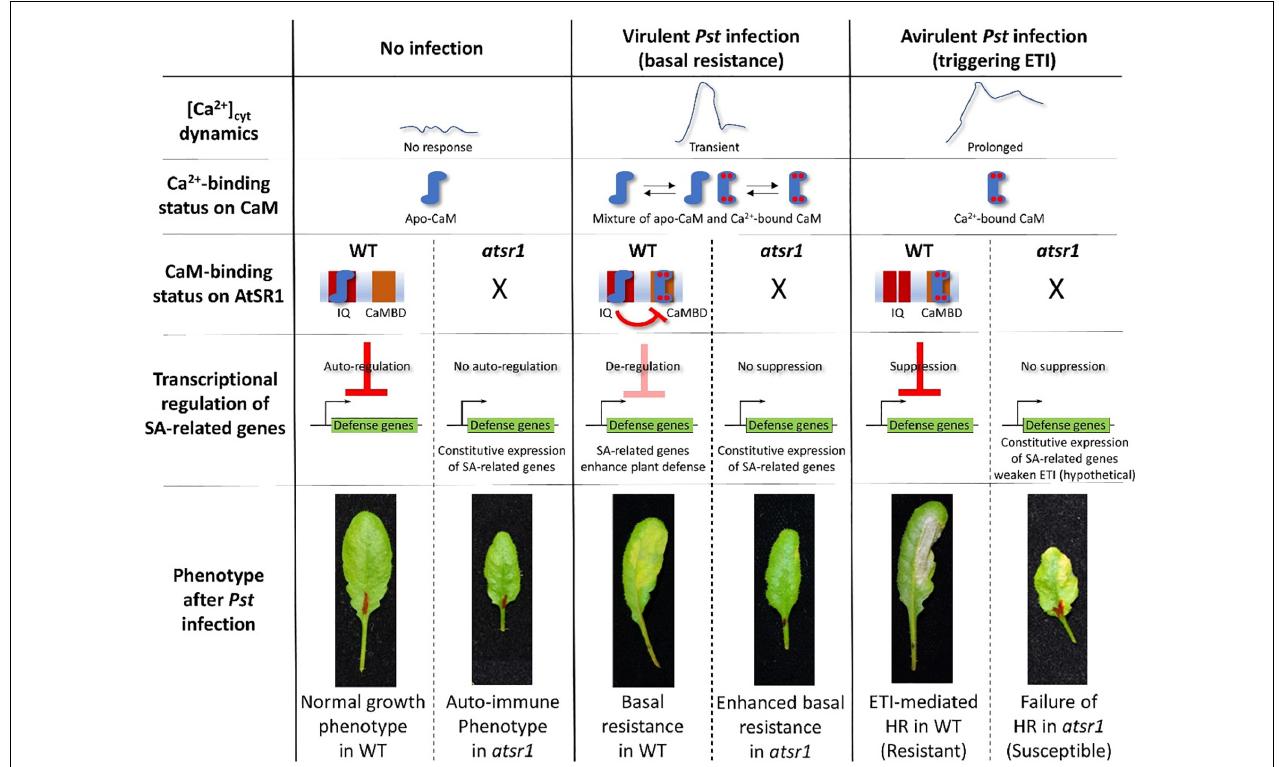
FIGURE 2 | AtSR1/CAMTA3 acts as a signaling switch with dependence on Ca 2 + -binding status of CaM during plant immune response. In non-stressful environments, there is no [Ca 2 + ] cyt dynamic. Hence, the status of CaM is not in a saturated phase at four Ca 2 + binding sites, designated as apo-CaM. Apo-CaM interacts with the IQ motifs of AtSR1. This CaM-AtSR1 complex may have an effect on the stability of AtSR1, which suppresses the transcriptional expression of defense-related genes (e.g., EDS1, ICS1, and NPR1 ) as an autoregulator. Thus, suppression of plant immunity maintains normal plant growth and development. Under the virulent pathogen infection, [Ca 2 + ] cyt is transiently increased, which confers a status of mixture of Apo-CaM and Ca 2 + -saturated CaM. Ca 2 + -saturated CaM interacts with the CaMBD of AtSR1, while Apo-CaM interacts with the IQ motifs. This CaM-AtSR1 complex loses its binding activity to the cis -regulatory element “CGCG,” and de-regulates the transcriptional expression of the defense-related genes. This eventually activates the basal resistance or PTI. Under avirulent pathogen infection, [Ca 2 + ] cyt is constitutively increased, which leads to stable binding of Ca 2 + ions to CaM. The Ca 2 + -saturated CaM interacts only with the CaMBD of AtSR1. This CaM-AtSR1 complex regulates the ETI-triggered PCD. In the atsr1 mutant, due to the loss of negative regulation of the NPR1 transcription by AtSR1, the plants constitutively activate basal immune response, resulting in the autoimmune phenotype. Under pathogen infection in the atsr1 mutant due to the lack of fine-tuning for transcriptional regulation of defense-related genes, the immune response is disturbed in the mutants, i.e., enhanced basal resistance and failure of ETI-induced PCD to the virulent and avirulent bacterial pathogens, respectively. Refer to Yuan et al. (2021) for further details. RDR6 and BN2, respectively. RDR6 is known to convert